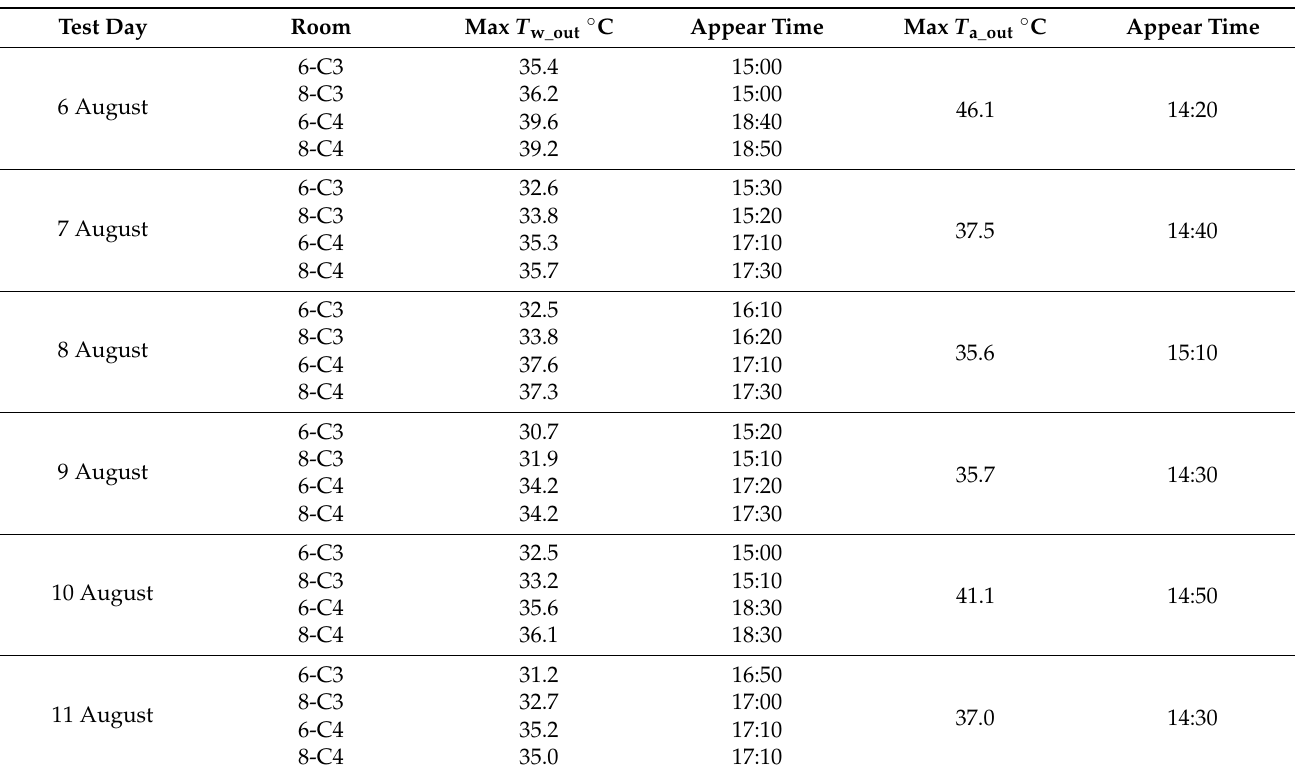
Table 4. The peaks of the outer wall surface temperature and outdoor air temperature, and the corresponding time of appearance for each